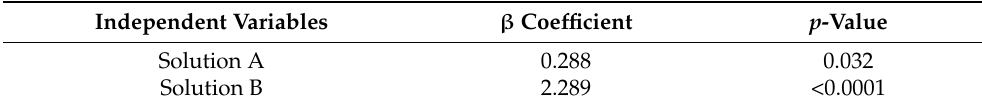
Table 3. Linear regression analysis for effect of independent variables on particle